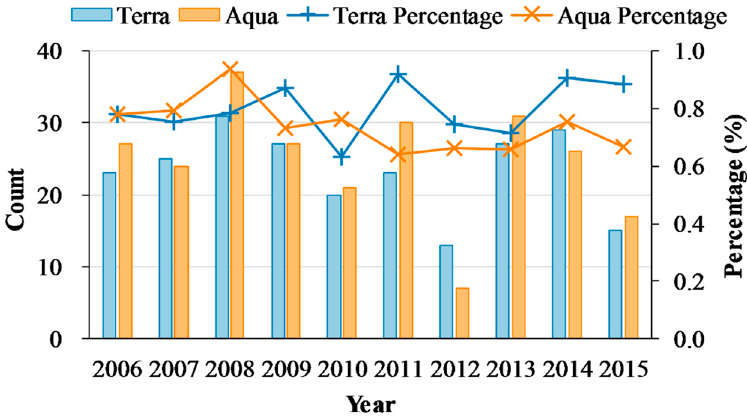
Figure 3. Number of days in each year that the DTDB 10 km AOD was partially derived from the DB 10 km AOD, and the mean percentage of pixels that were contributed by the DB 10 km AOD during these days.